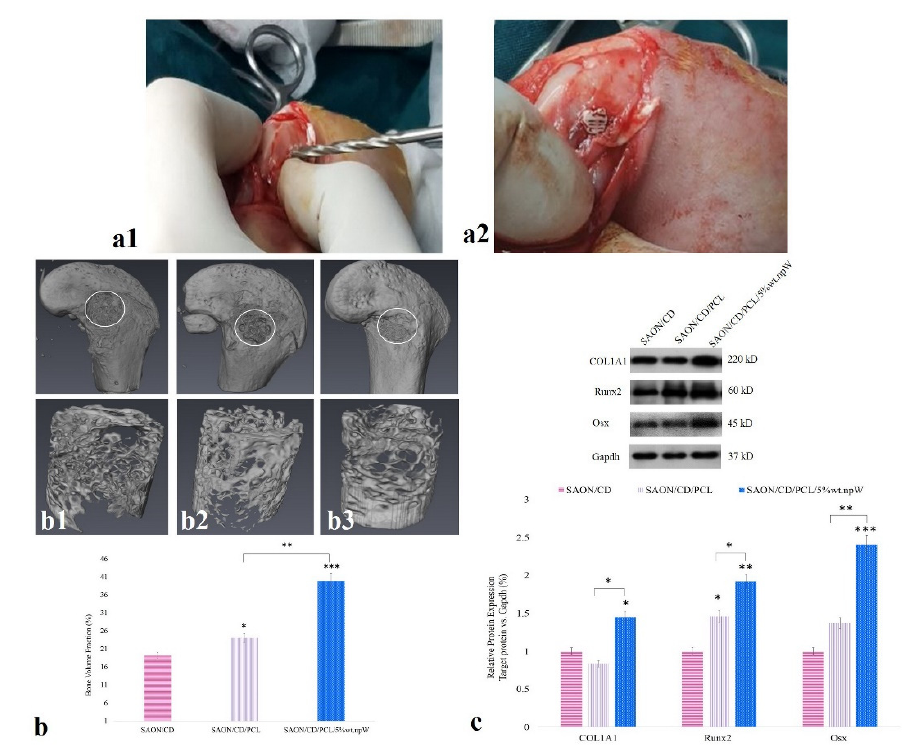
Figure 7. In vivo bone regeneration. ( a1 ) Creation of 10 mm diameter CD. ( a2 ) Press-fitted the neat PCL and PCL/5% wt. npW scaffold into the bone CD tunnel. ( b1 – b3 ) Micro-CT analysis of SAON/CD, SAON/CD/neat PCL, and CD/PCL/5% wt. npW groups at 2 months post-steroid injection. ( c ) Western blots were used to determine the expression of the proteins Col1A1, Runx2, and Osx in the tissue of the distal femur normalized to Gapdh expression. Results showing mean ± SD of at least three independent experiments. * p < 0.05; ** p < 0.01; *** p < 0.001 compared to SAON/CD.